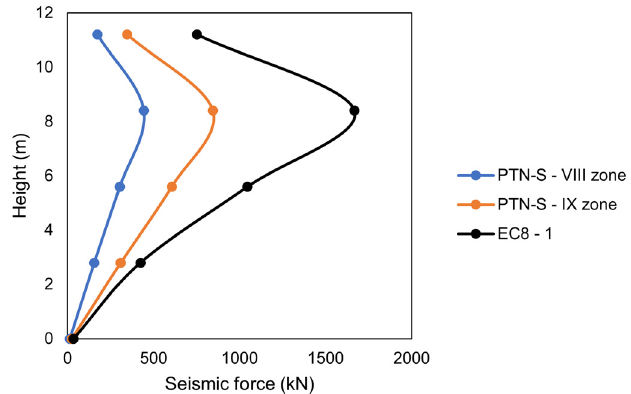
Figure 23. Applied seismic forces for the case study building at story levels determined according to the PTN-S code (seismic intensity VIII and IX) and EC8-1 (a g = 0.2 g, ground type B, q = 1.5, and q = 2.5).